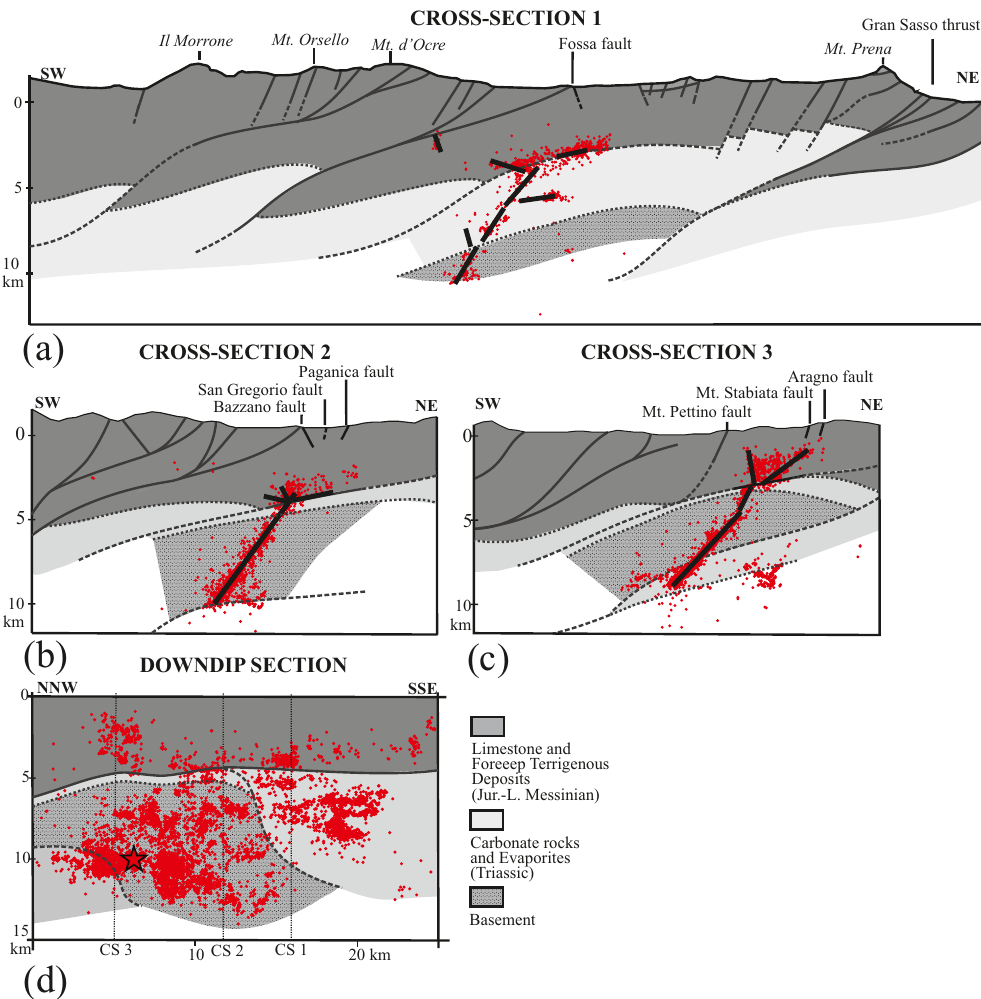
Figure 5. Geological sections across the L’Aquila area. (a) Regional geological section showing the main tectonic features of the area (modified after Satolli and Calamita, 2008 and Vezzani et al., 2009). (b) and (c) : geological sections across the central (b) and northern (c) parts of the L’Aquila seismogenic source. (d) Down-dip section (strike N135E; dip 50 ◦ to the WSW). In all sections red dots indicate relocated aftershocks (Valoroso et al., 2013). In all figures thick black lines represent fault segments from Valoroso et al. (2013) based on the analysis of the aftershock locations and focal mechanisms. Red star is the hypocenter of the April 6 mainshock.